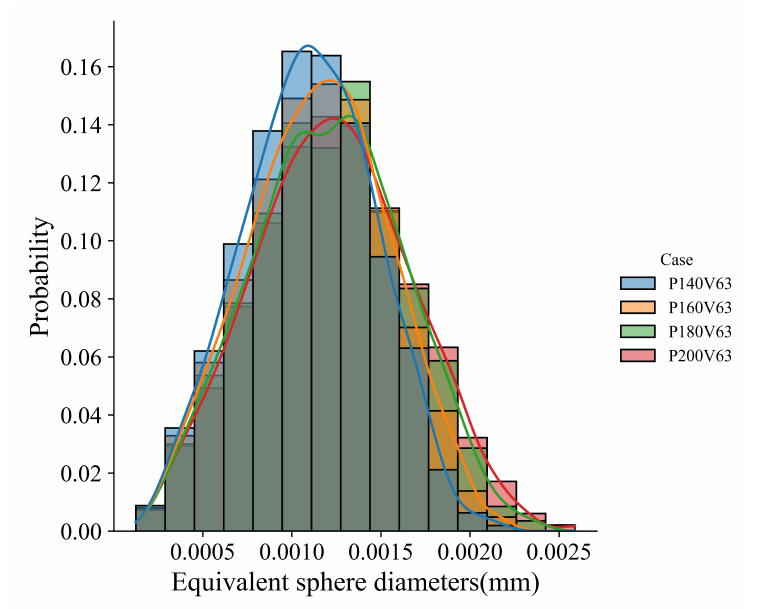
Figure 12. Grain size distributions for cases with laser power varied within the range of [140 W, 200 W] and the constant laser scan speed of 0.63